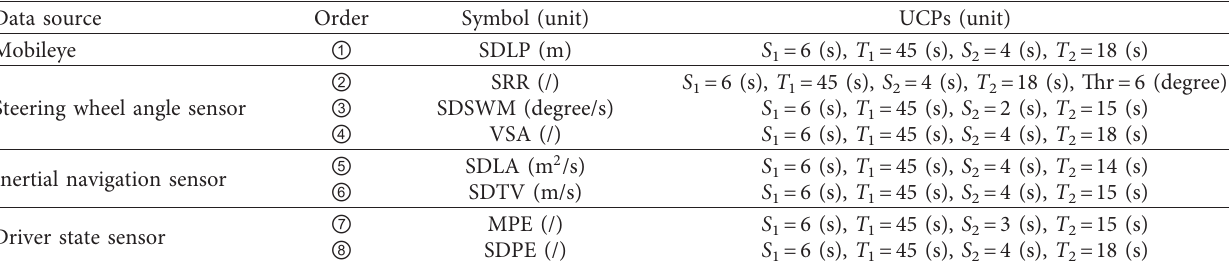
Figure 3: Graph of KSS changes of all participants over time. Table 2: The information on nonintrusive drowsiness-related